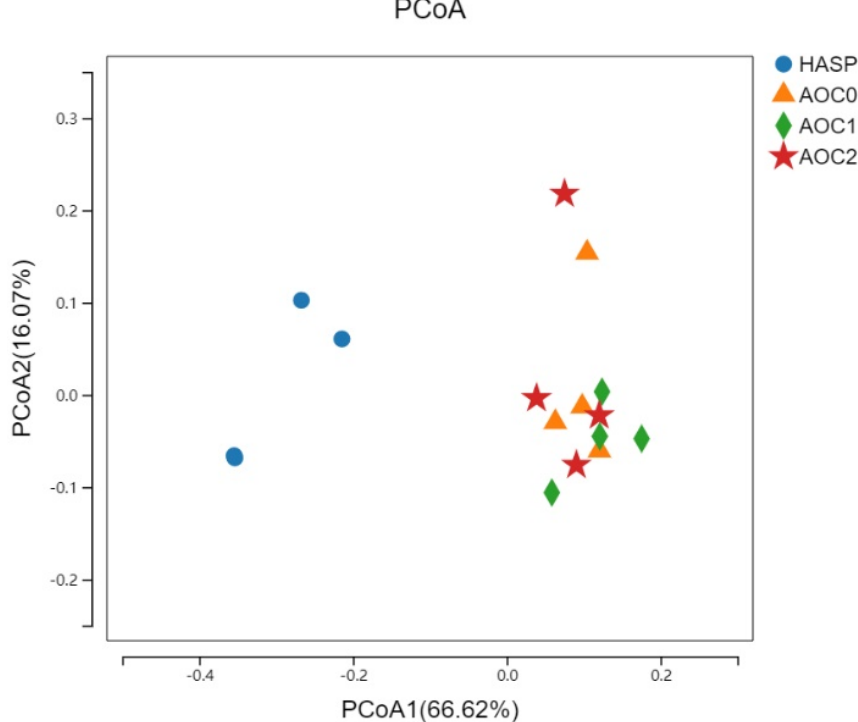
Figure 1. Two dimensional PCoA plots based on weighted_unifrac distance.